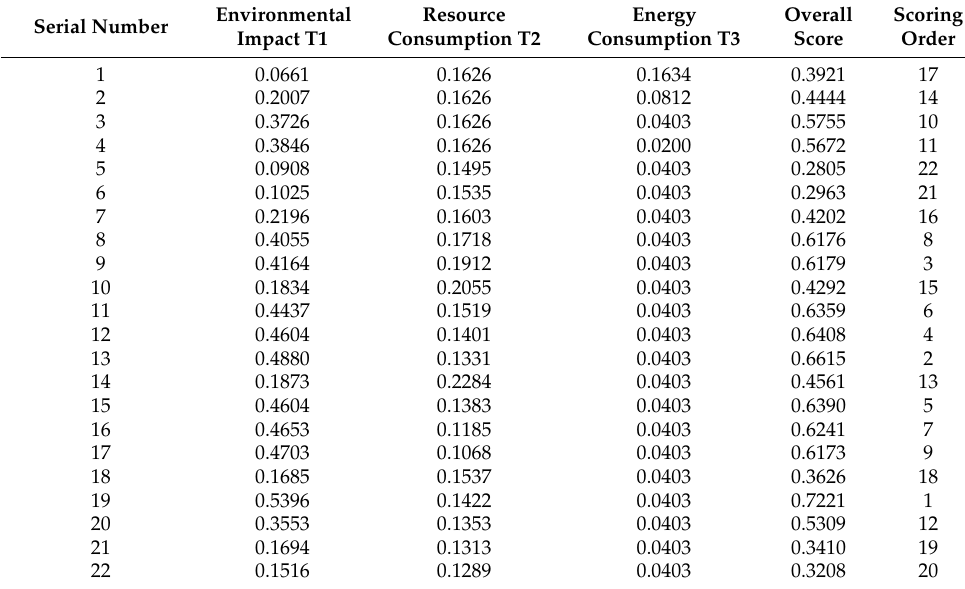
Table 4. Comprehensive evaluation score and ranking of each experiment order.